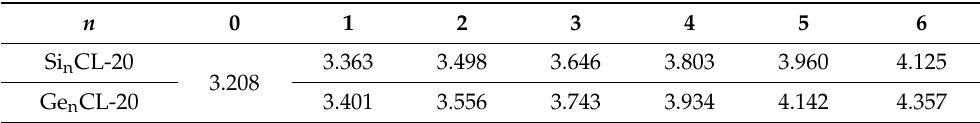
Table 1. The effective diameters D eff (Å) of Si n CL-20/Ge n CL-20 obtained at the DFT/B3LYP/6- 311G(d,p) level of